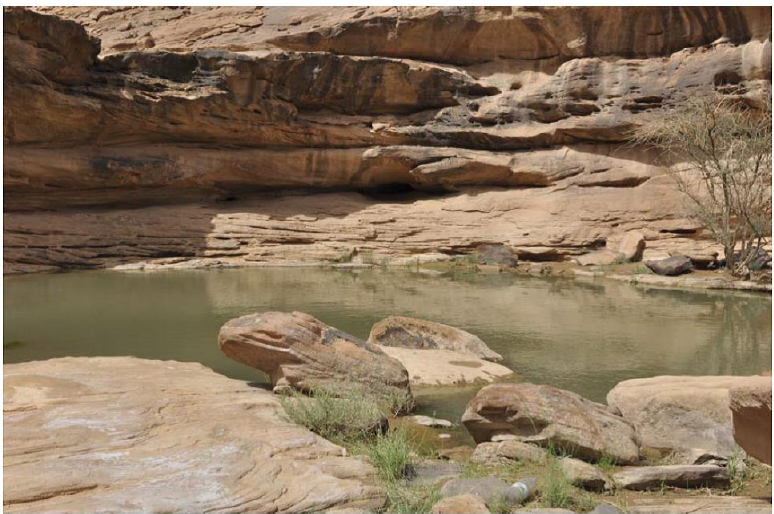
Figure 14. Alia and several Thamudic inscriptions are carved on the hill around the rain water reservoir at the base of Jabal al-Kaukab,